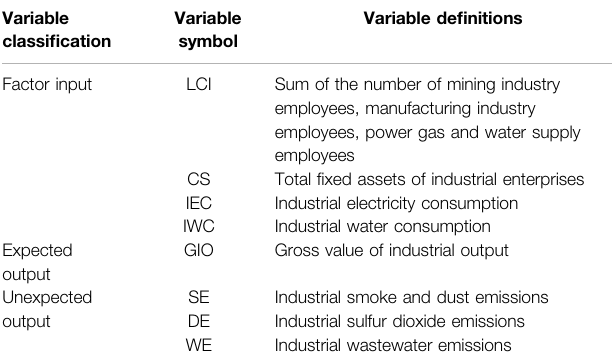
TABLE 1 | Parameters of industrial green transformation. Variable classi fi